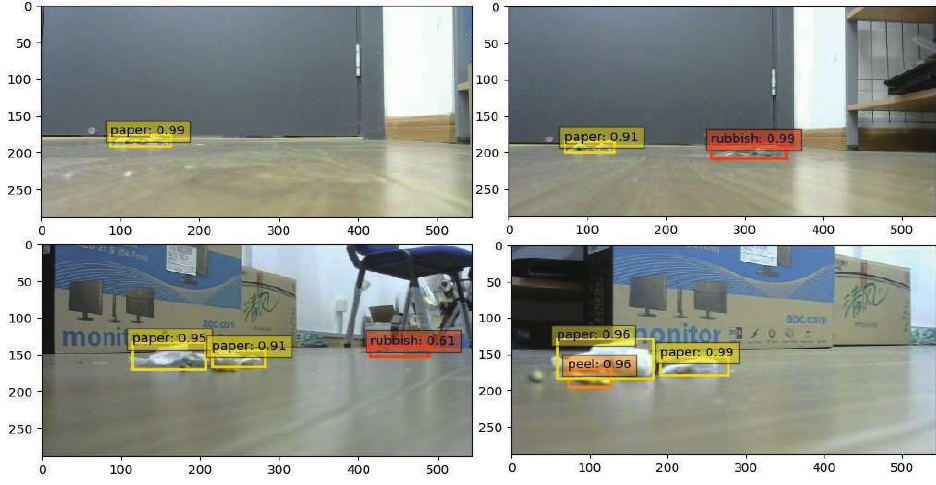
Figure 11. Indoor floor garbage detection experiment